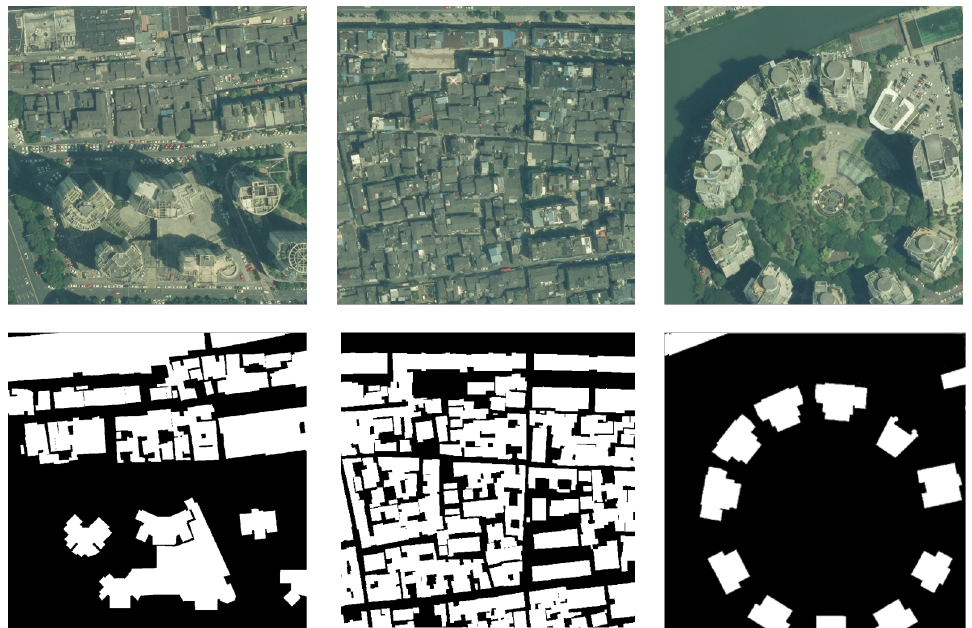
Figure 3. Pairs of images with labels. The top row is the aerial remote sensing image, and the bottom row is the corresponding building label.